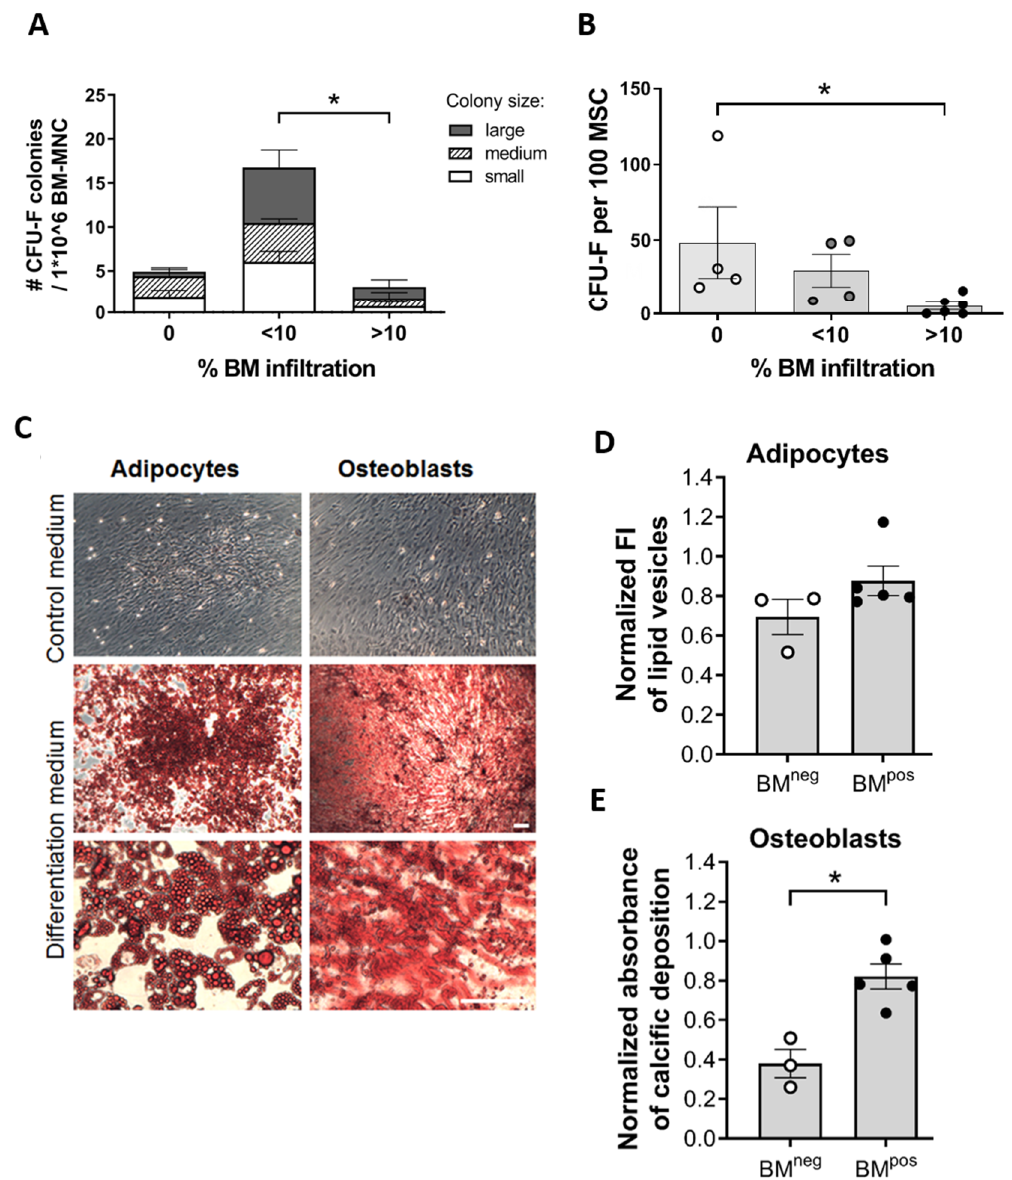
Figure 3. The MSC compartment of metastatic BM is characterized by a lower CFU-F capacity per 100 MSCs and an increased di ff erentiation potential towards osteoblasts. ( A , B ) The clonogenic potential of MSCs was determined by a Colony-forming unit-fibroblast (CFU-F) assay to determine the frequency of stromal progenitors. BM infiltration is determined by qPCR. ( A ) Average colony number per 1 × 10 6 MNCs of BM as well as colony size from NB-patients with and without BM metastases. Experiments were carried out in triplicate. ( B ) number of colonies per 100 MSC for NB-patients with and without BM metastases. ( C – E ) Di ff erentiation capacity of MSCs. ( C ) MSCs isolated from BM of localized- and metastatic-NB patients and adult BM, were assayed for their di ff erentiation capacity. After 3 weeks of culturing in the respective di ff erentiation medium, cells were stained for lipid vesicles of adipocytes (using Oil red O) or for calcium deposits, as an indicator of osteogenesis (Alizarin Red S), and nuclei (Hoechst). Scale bar = 50 µ m ( D , E ) Quantification of di ff erentiated cells. Metastatic disease in the BM is defined based on qPCR positivity as BM pos and qPCR negativity as BM neg (D: adipocytes, E: osteoblasts). (*) p < 0.05 .